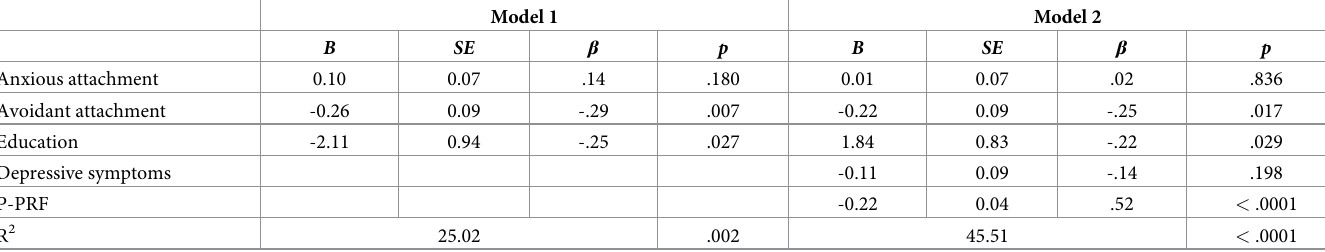
Table 5. Multiple regression results for MAAS intensity of preoccupation.